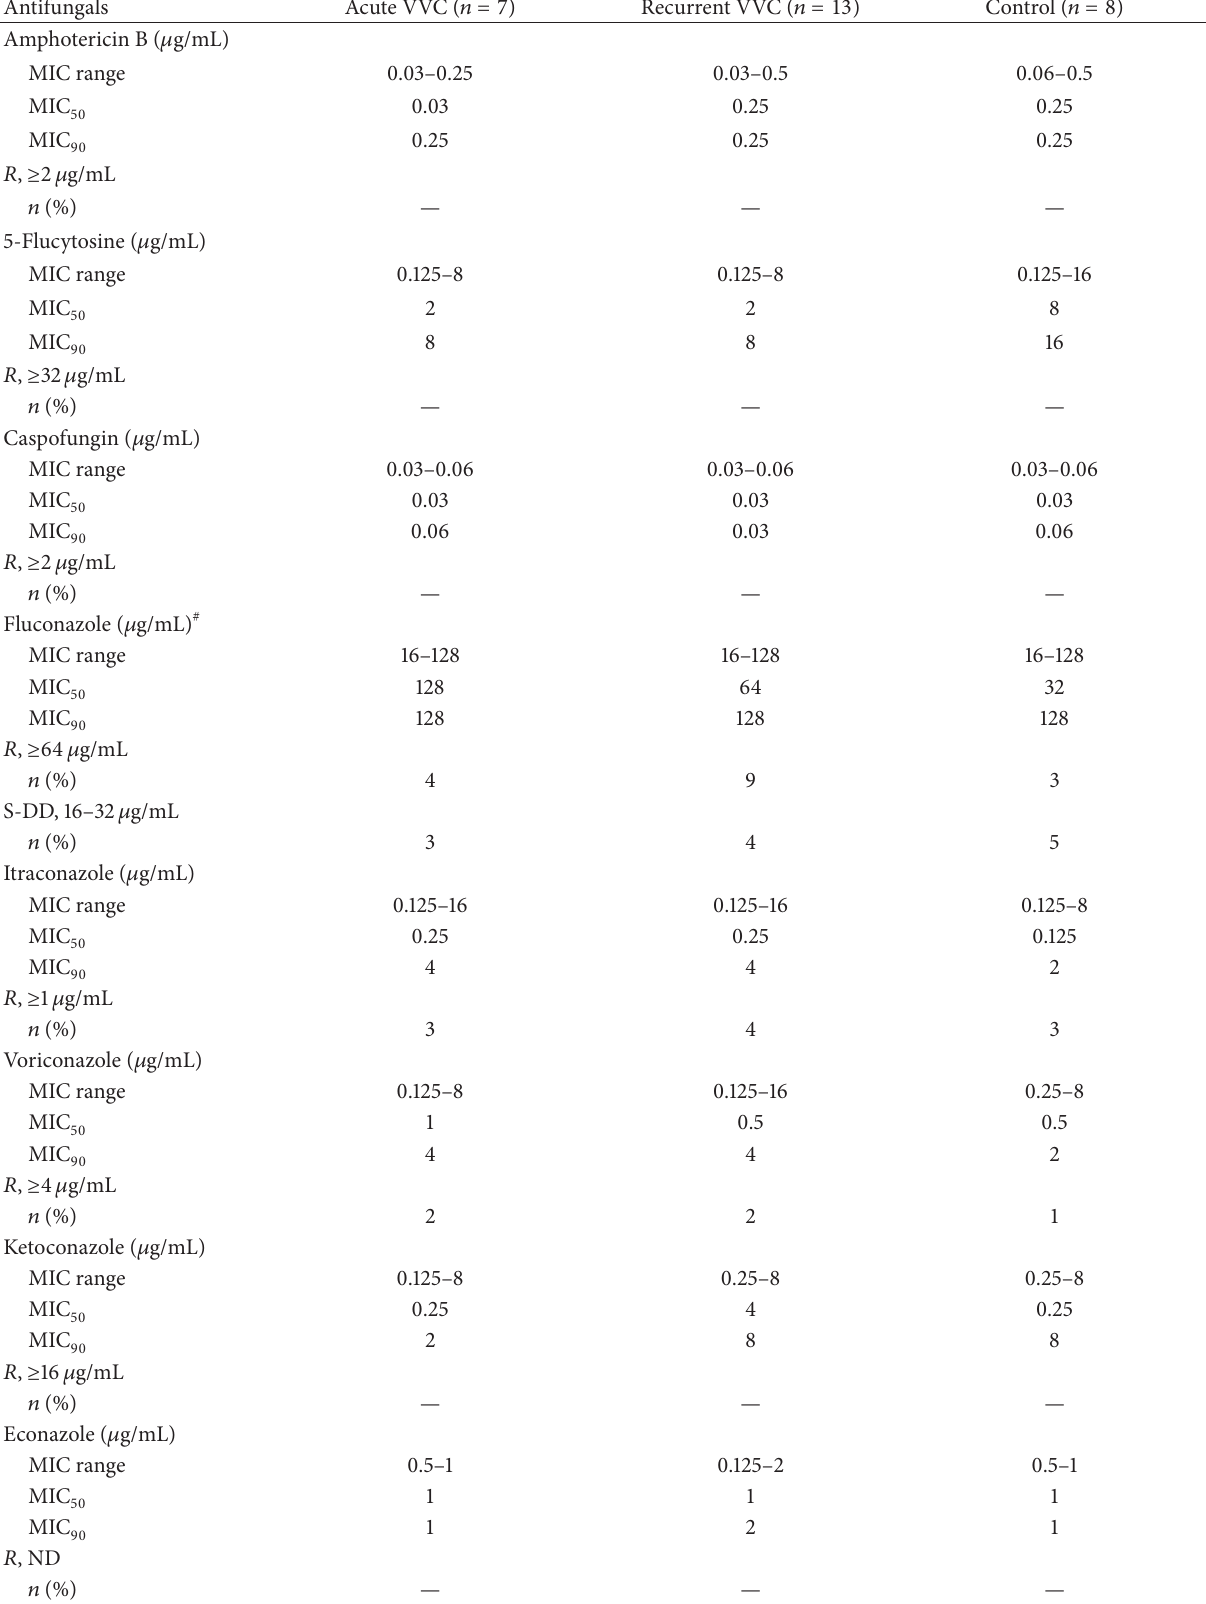
Table 4: Antifungal susceptibility of 28 vaginal Candida krusei isolates stratified according to clinical